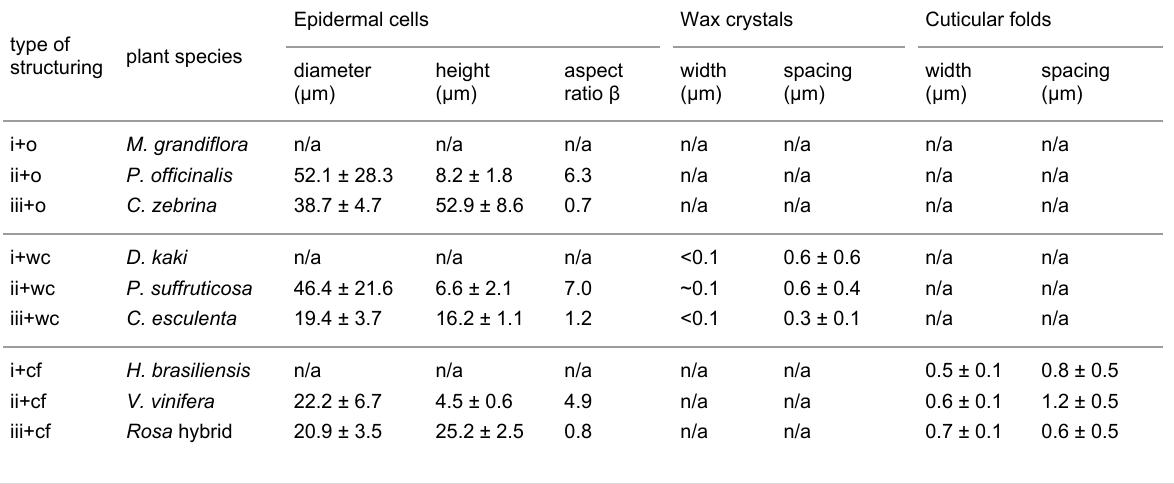
Table 1: Dimensions of structuring of plant surfaces tested ( n = 10). Aspect ratio β = width/height of epidermal cell curvature. n/a = not applicable.